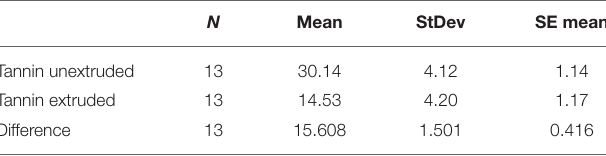
TABLE 5 | Paired t -test of condensed tannin contents of unextruded and extruded composite flour. N Mean StDev SE mean Tannin unextruded 30.14 Tannin extruded Difference